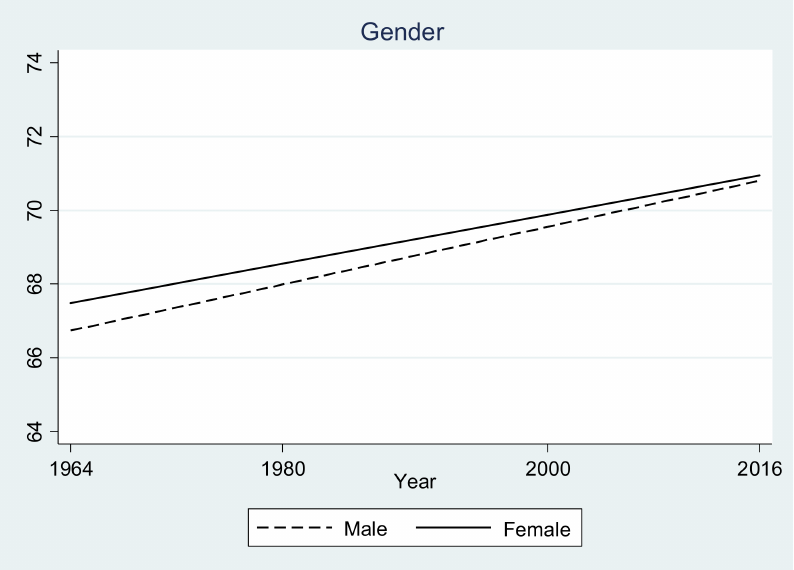
Figure 6. Impact of gender on the Jewish feeling thermometer, 1964–2016. Based on results from Table 3. Source: American National Election Studies, 1964–2016.